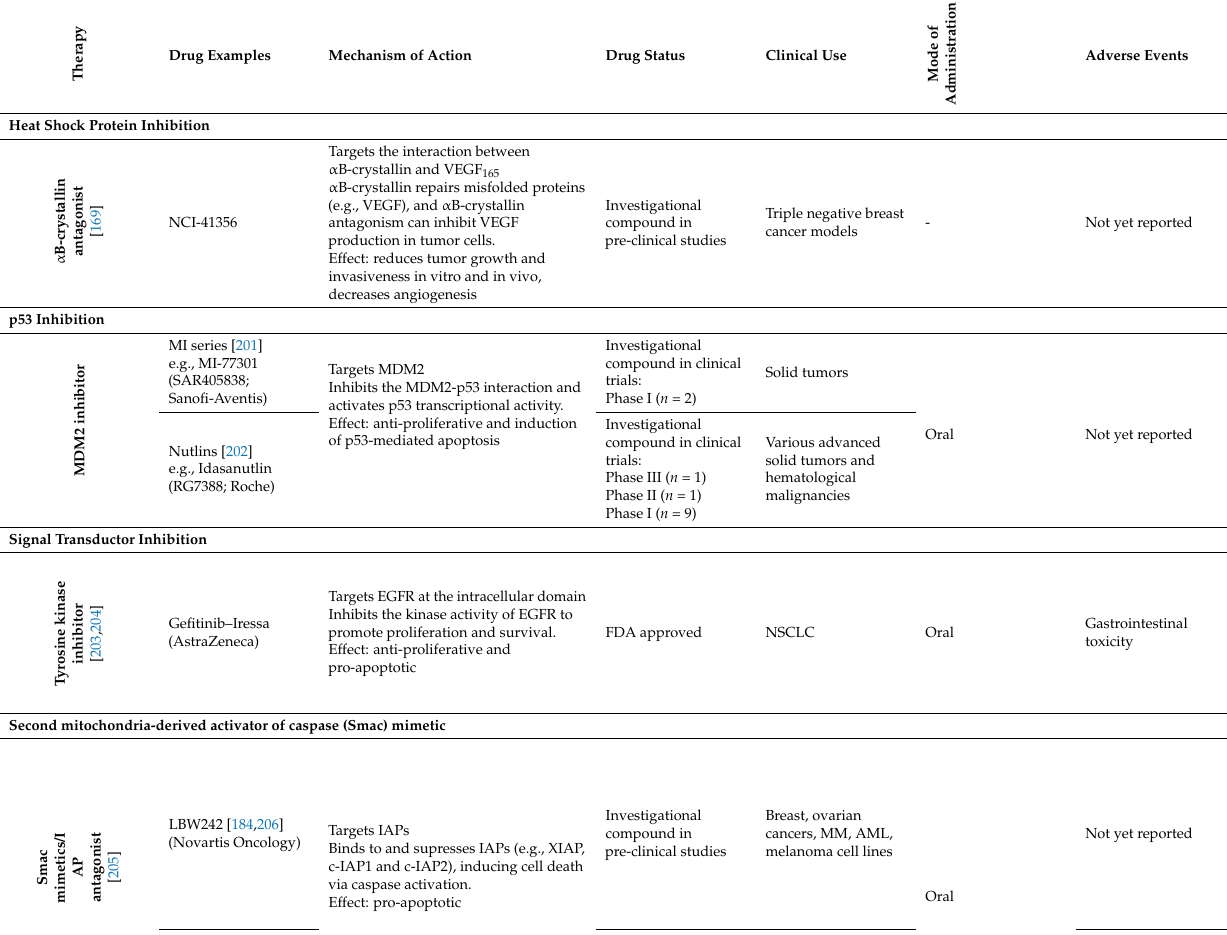
Table 2. Targeting apoptosis and survival in